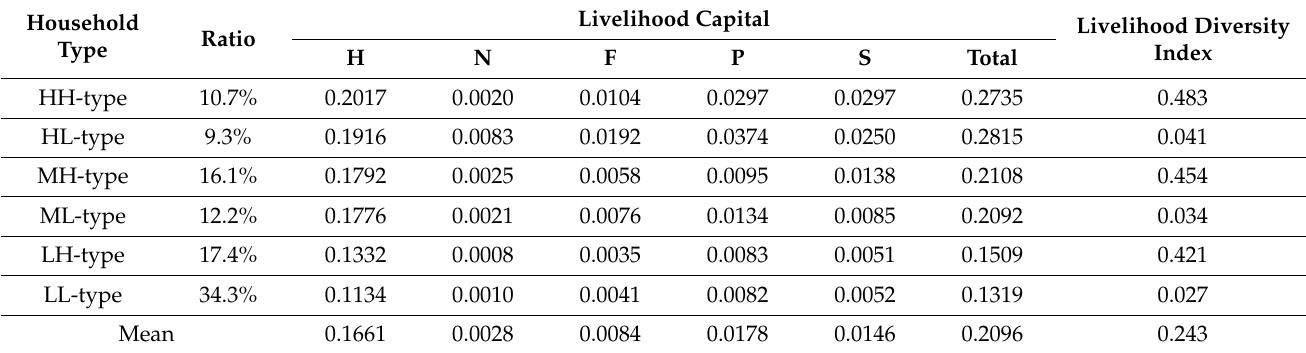
Table 6. Household livelihood capital and livelihood diversity